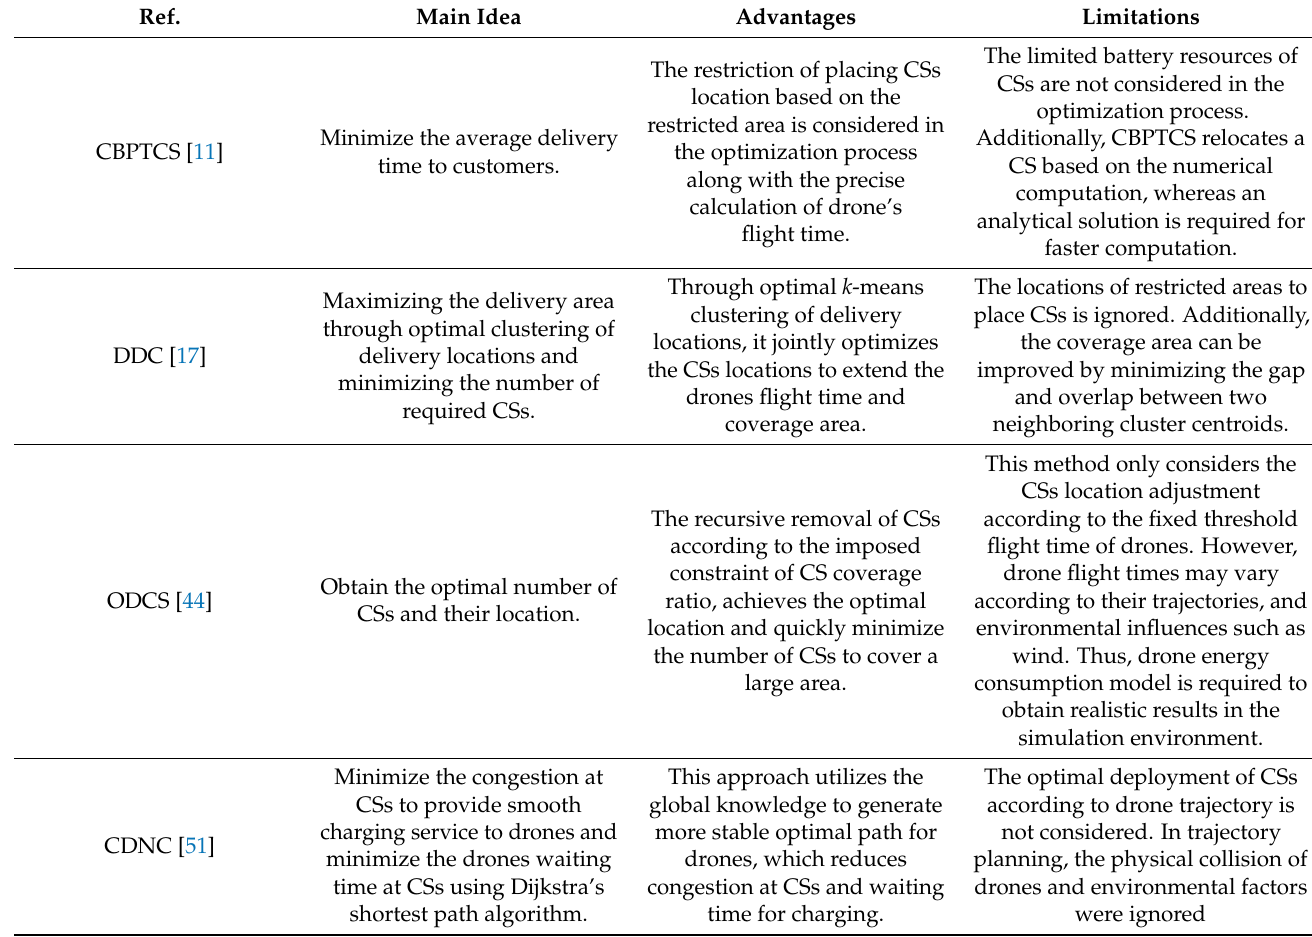
Table 4. Comparison of charging algorithms in drone routing in terms of main idea, advantages, and